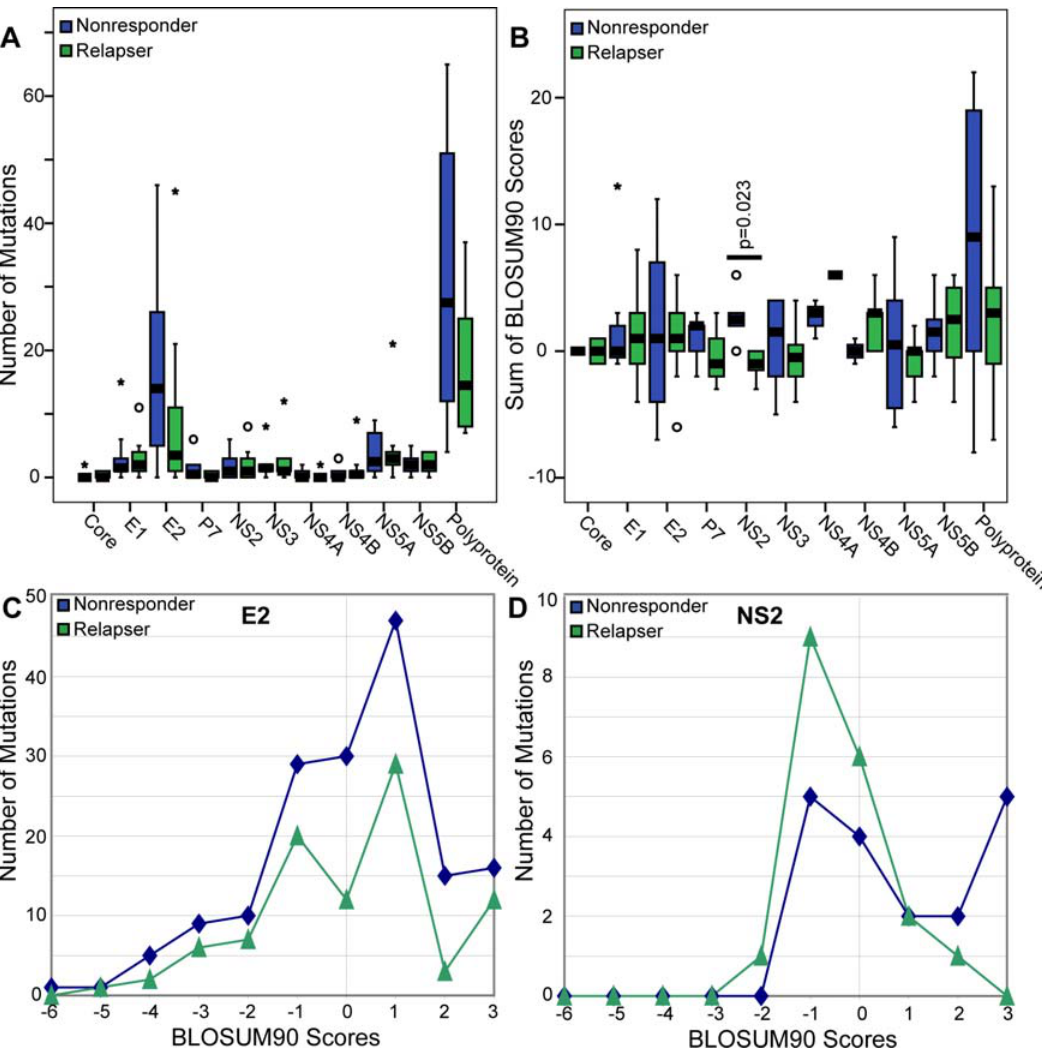
Figure 6. Mutations in nonresponder and responder sequences over the course of therapy. A) The number of changes in nonresponders and relapsers were compared using Mann-Whitney test. One relapser does not appear on the chart (113 changes). B) The sums of the BLOSUM90 score for all of the changes occurring in a given sample were compared between nonresponders and relapsers. Totals were compared using a Kolmogorov-Smirnov test. C) Distribution of BLOSUM90 scores for E2. D) Distribution for BLOSUM90 scores for NS2.